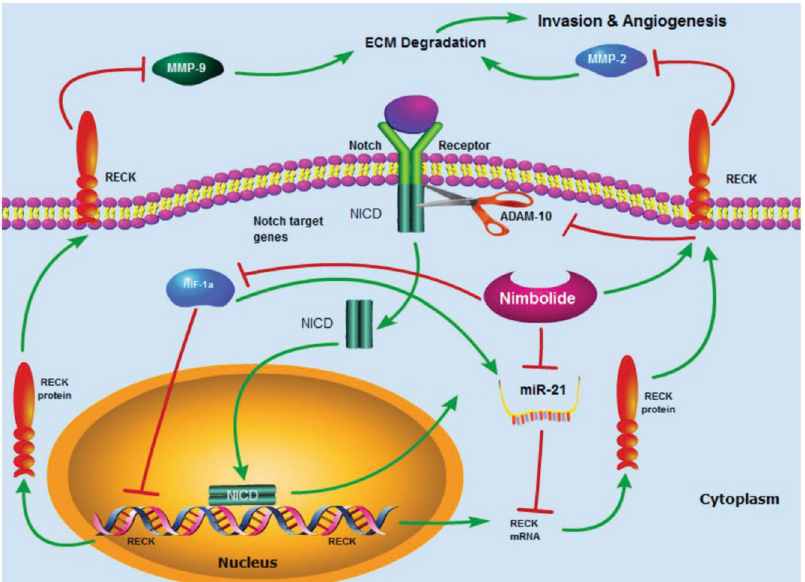
Figure 8. Schematic representation of the mechanism of action of nimbolide. Dietary administration of nimbolide activates RECK and prevents ECM degradation, and blocks activation of Notch signalling and HIF-1 α mediated VEGF signalling thereby inhibiting angiogenesis. Nimbolide also inhibits miR-21, a negative regulator of RECK. Nimbolide prevents cancer progression by modulating the expression of genes and pathways involved in invasion and angiogenesis as well as by targeting